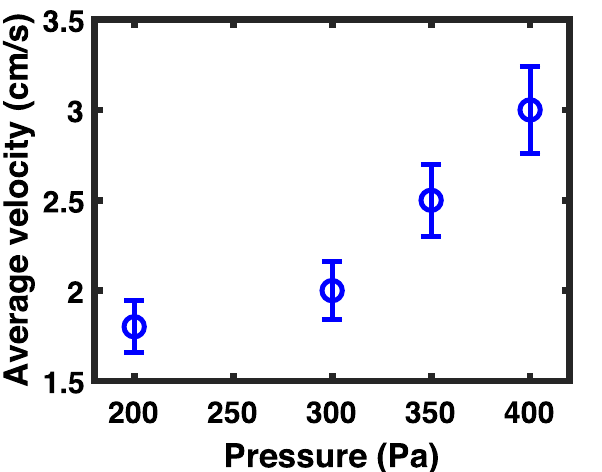
Figure 4. Variation of the average velocity of dust layer with the input pressure of pulse valve at a constant chamber pressure of 11